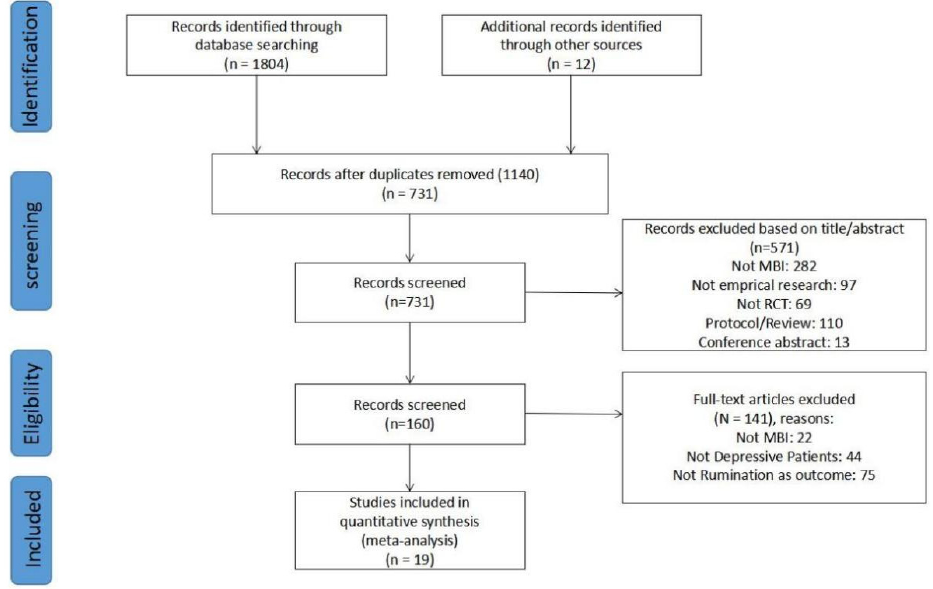
Figure 1. Flow chart of the study selection process.